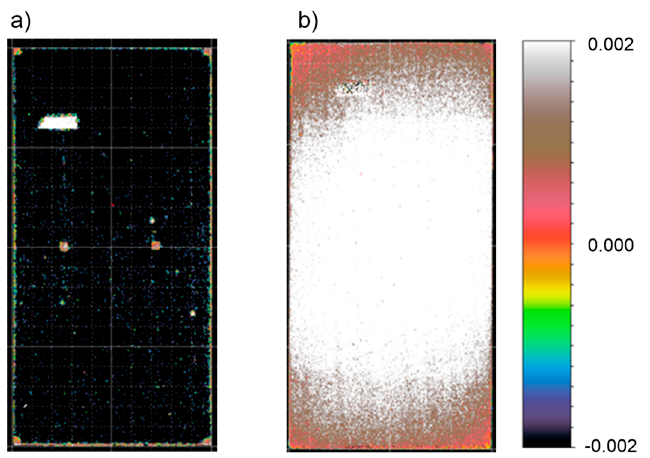
Figure 18. Deformation map of spot-glued panels obtained from 3D scanner readings, ( a ) C-type panel, ( b ) B-type panel.